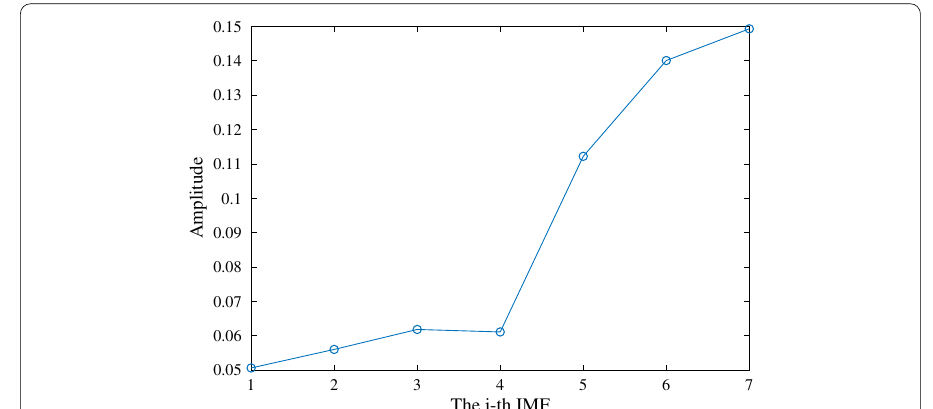
Fig. 8 The energy probability of the singular spectrum of each IMF